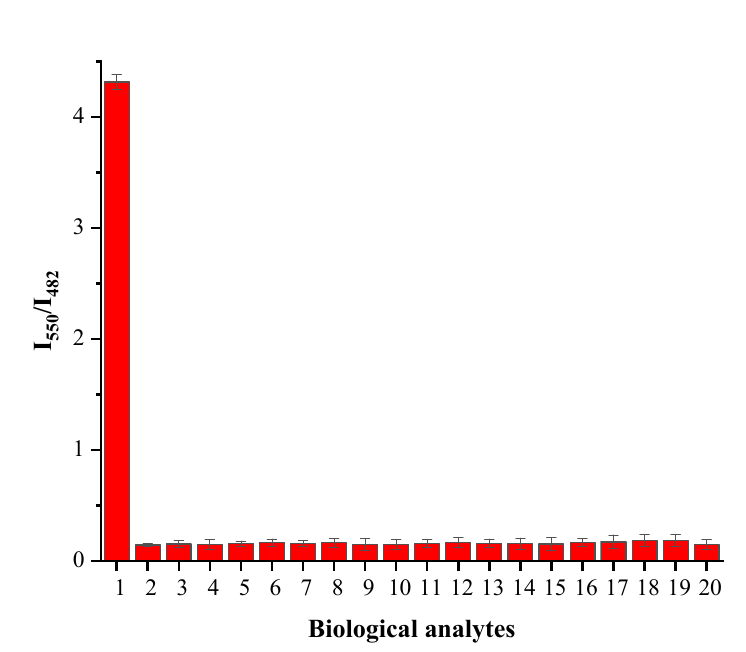
Figure 5. Fluorescent intensity ratios I 550 / I 482 responses of 1 µ M Q7 to biological analytes (1 mM). Legend: (1) Sec; (2) Blank; (3) Hcy; (4) GSH; (5) Cys; (6) Pro; (7) Glu; (8) Asp; (9) Phe; (10) Thr; (11) Val, (12) Leu, (13) Arg; (14) Ile; (15) Ser; (16) Trp; (17) Lys; (18) His; (19) Na 2 SeO 3 ; (20) Na 2 Se. Excitation at 400 nm. Each data point was detected after mixing for 4 min.